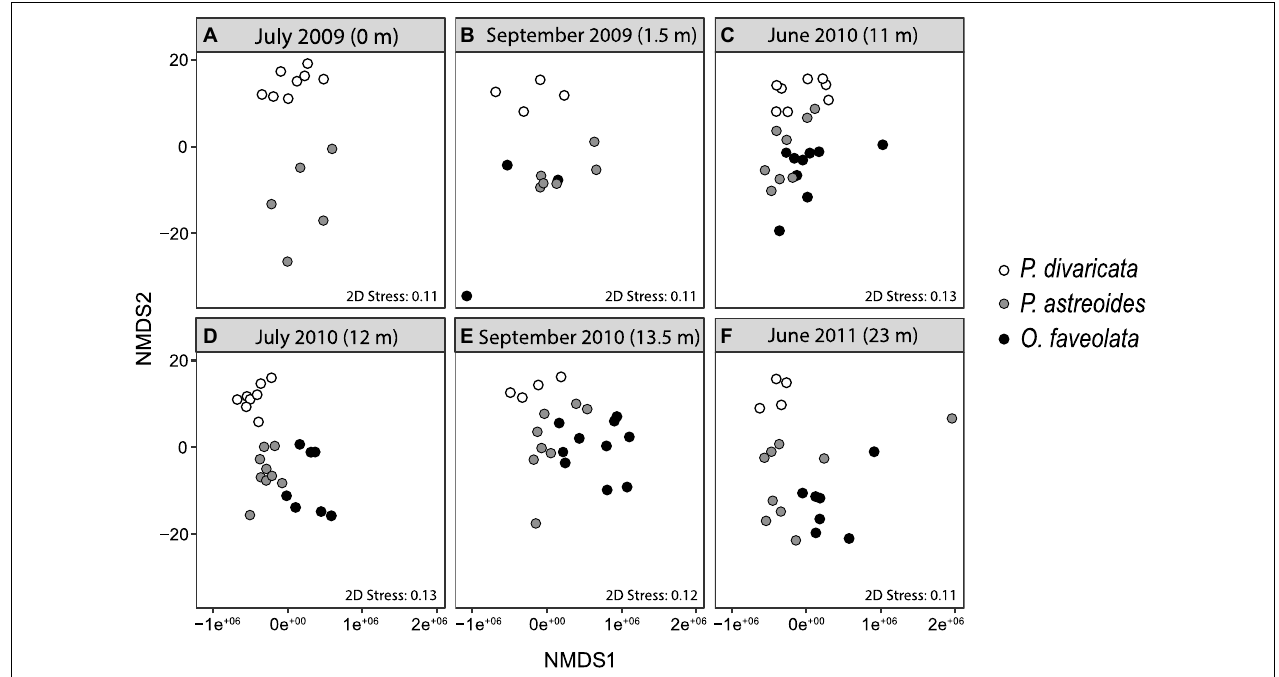
FIGURE 3 | Multivariate NMDS plots for Porites divaricata (white), Porites astreoides (gray), and Orbicella faveolata (black) at (A–F) each time point ( m = months). Variables included in the analyses were calcification, biomass, lipids, proteins, carbohydrates, chlorophyll a , Symbiodiniaceae density, and δ 13 C h − e . Corresponding PERMANOVAs in Tables 2 , 3 . TABLE 3 | Results of the pair-wises tests of the one-way PERMANOVAs testing differences among physiological profiles of coral species ( Porites divaricata, Porites astreoides, Orbicella faveolata ) within each time point. Time Groups